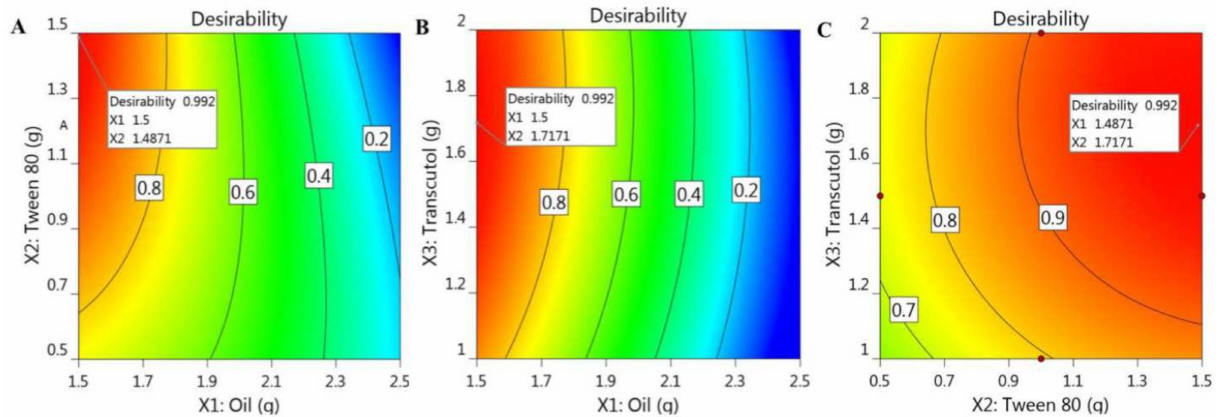
Figure 8. Optimization figures screening the influence of ( A ) X 1 and X 2 , ( B ) X 1 and X 3 , and ( C ) X 3 and X 2 on overall